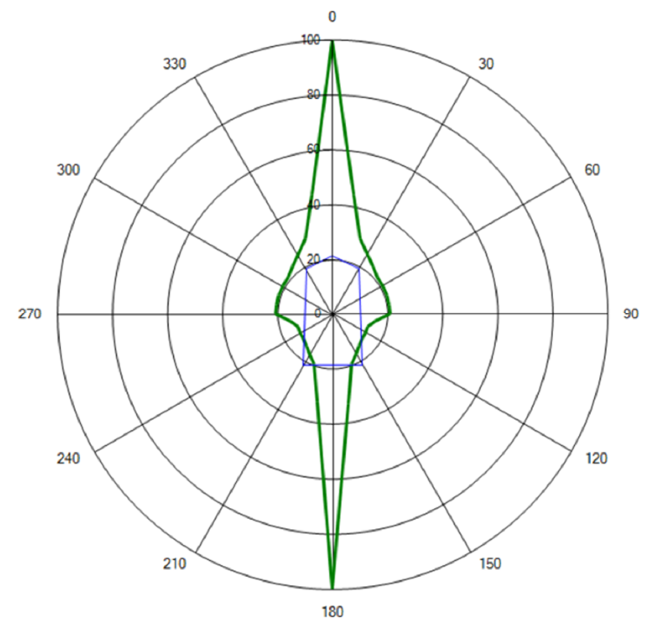
Table 7. Thrusters data for a ship with an anchor set.